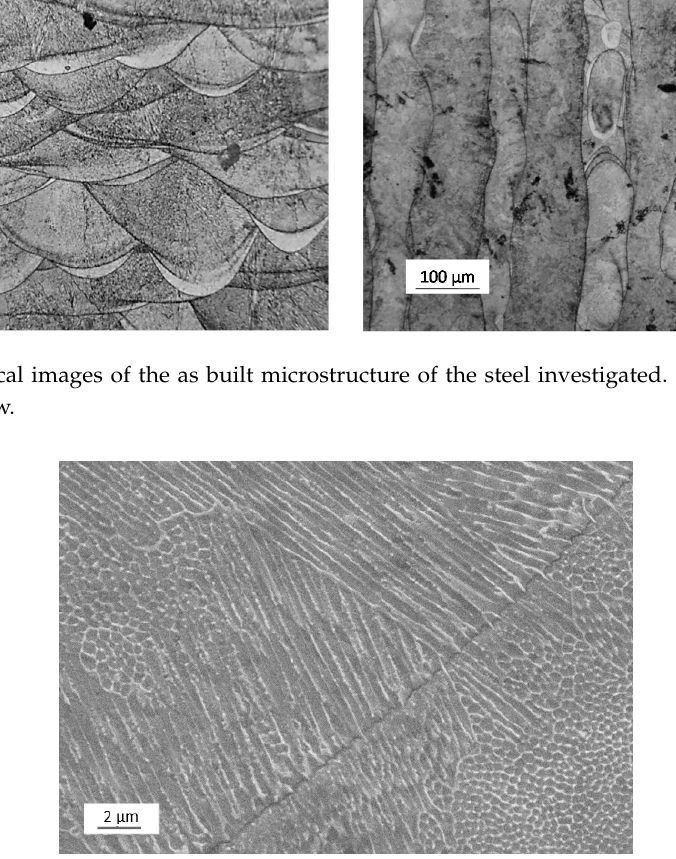
Figure 4. SEM image of the cellular solidification microstructure and epitaxial growth across a track boundary .